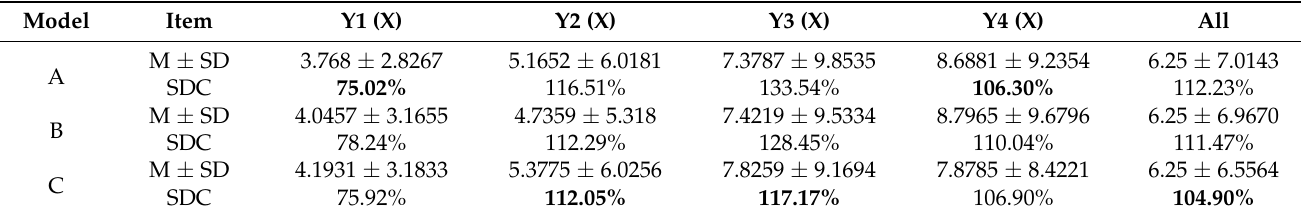
Table 8. Statistical table of the mean (M), standard deviation (SD), and standard deviation coefficients (SDC) of percentage distributions along the X -axis on coordinates Y1, Y2, Y3, and Y4: (A) single threshing gap of 15 mm; (B) single threshing gap of 10 mm; (C) multi-threshing gaps of 10 mm and 15 mm.